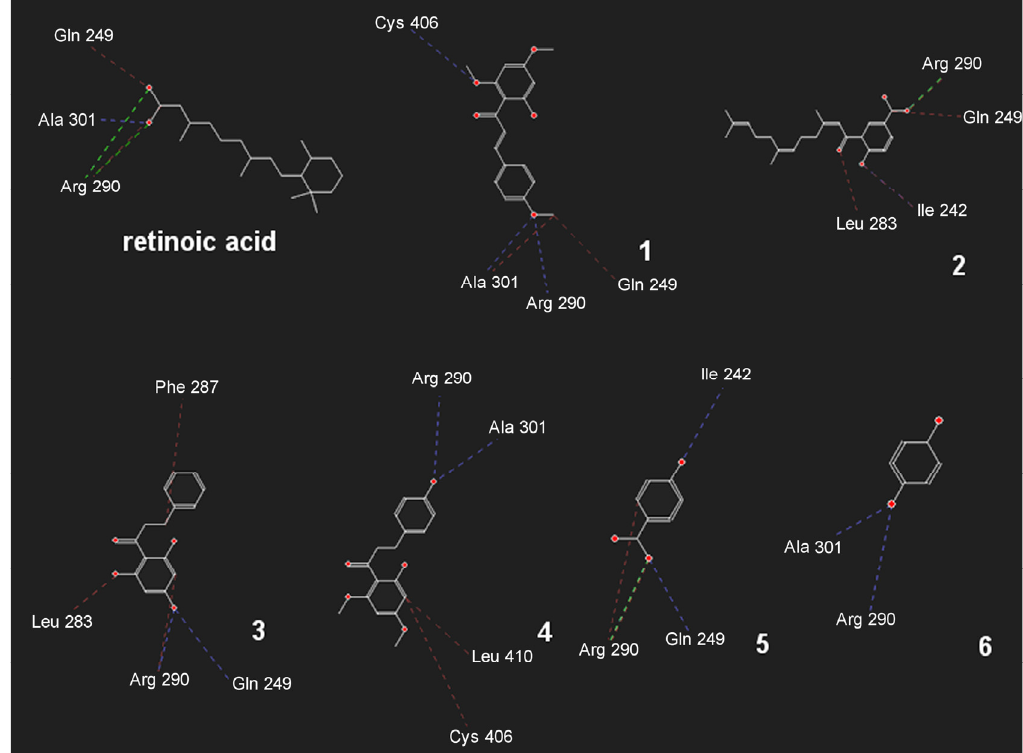
Figure 2. Best docking results showing electrostatic (green), hydrogen bonds (blue) and hydrophobic (red) interactions between the ligands and active site of RXR-protein like of Biomphalaria glabrata (PDB code: